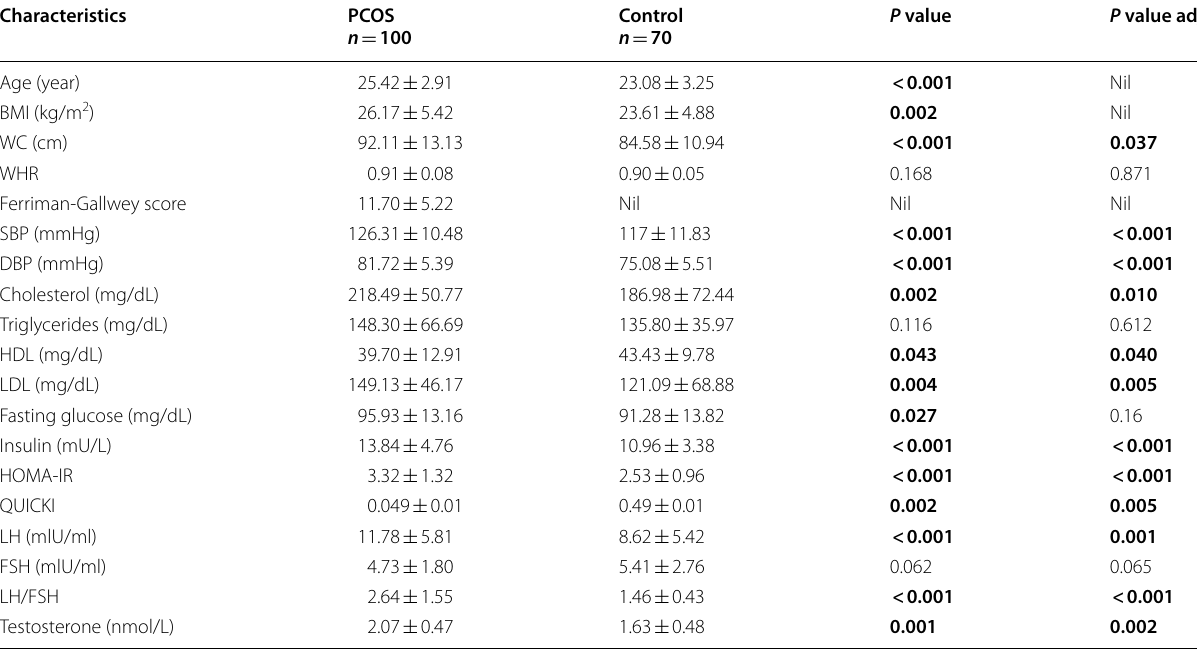
BMI, Body mass index; WC, waist circumference; WHR, waist-to-hip ratio; SBP, systolic blood pressure; DBP, diastolic blood pressure; HDL, high-density lipoprotein; LDL, low-density lipoprotein; HOMA-IR, homeostasis model for insulin resistance; QUICKI, quantitative insulinsensitivity check index; LH, luteinizing hormone; FSH, follicle- stimulating hormone Values are expressed as mean standard deviation (Student’s t test); Bold values indicate significant P -values ( P ± and BMI through ANCOVA (analysis of covariance)